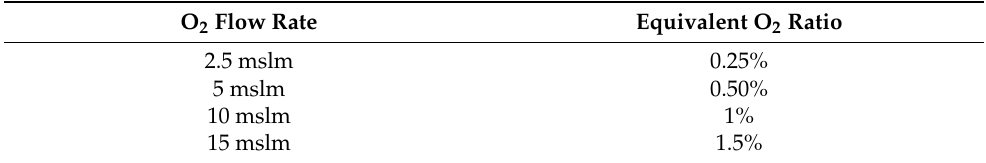
Table 2. Equivalent O 2 flow rate ratio.